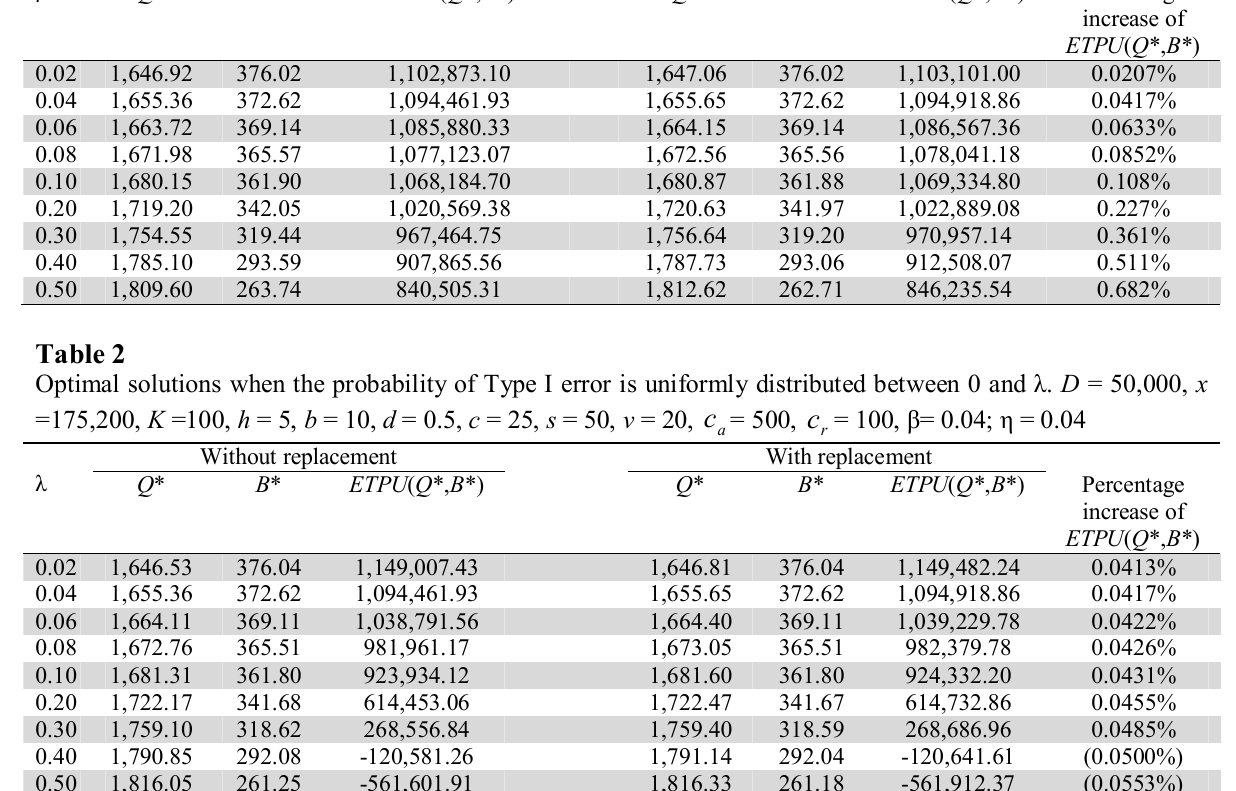
c = 500, c = 100,λ= 0.04; η = 0.04. a r